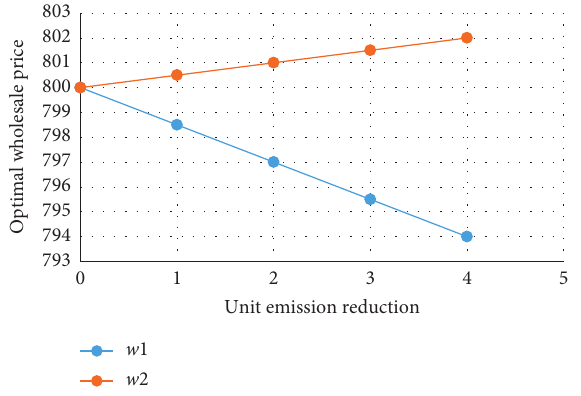
Figure 3: Wholesale price comparison chart.